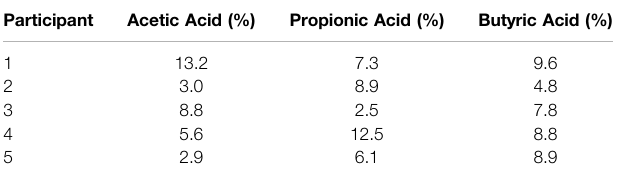
TABLE3| RepeatabilityofSCFAsconcentrations(relativestandarddeviations)for fi ve consecutive exhaled breath samples from fi ve individuals measured with SRI/PTR-ToF-MS with H 3 O + as reagent ion.